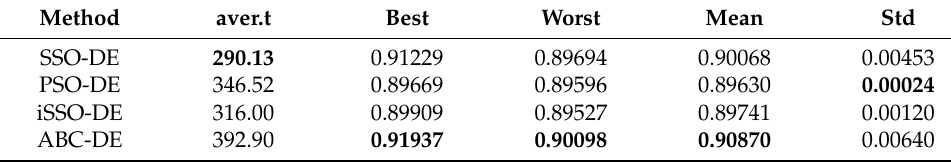
Table 22. Experiment results for summer.